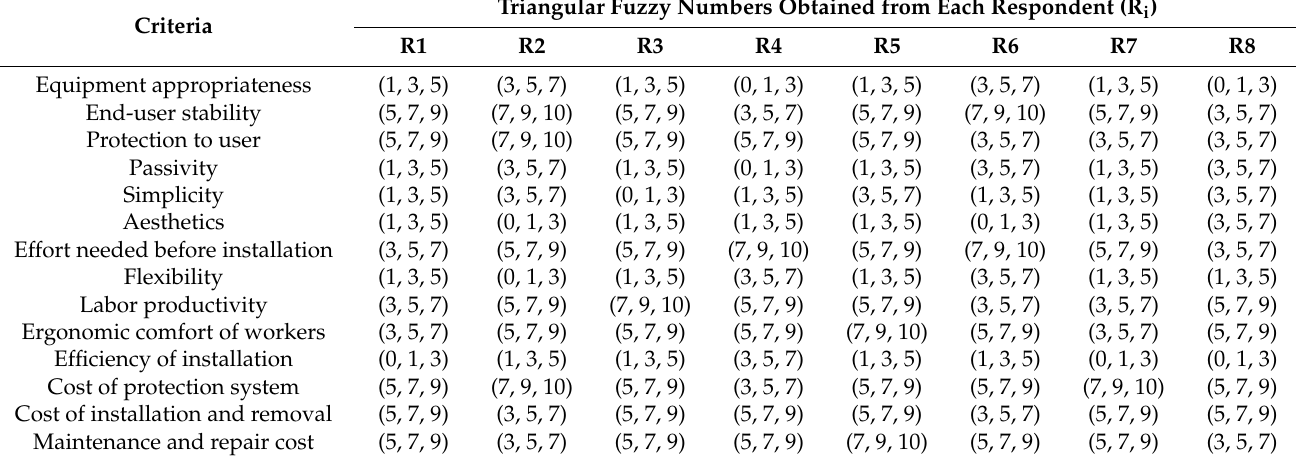
Table 7. Matrix of fuzzy evaluation data for Alternative